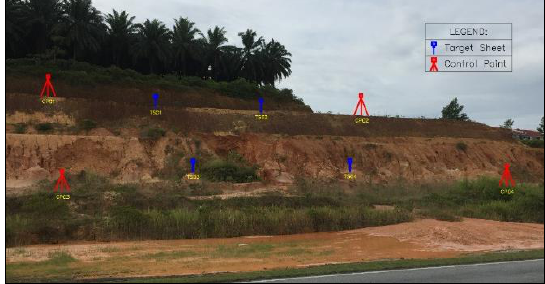
Figure 14. The distribution of the control points and target sheets on the land slope